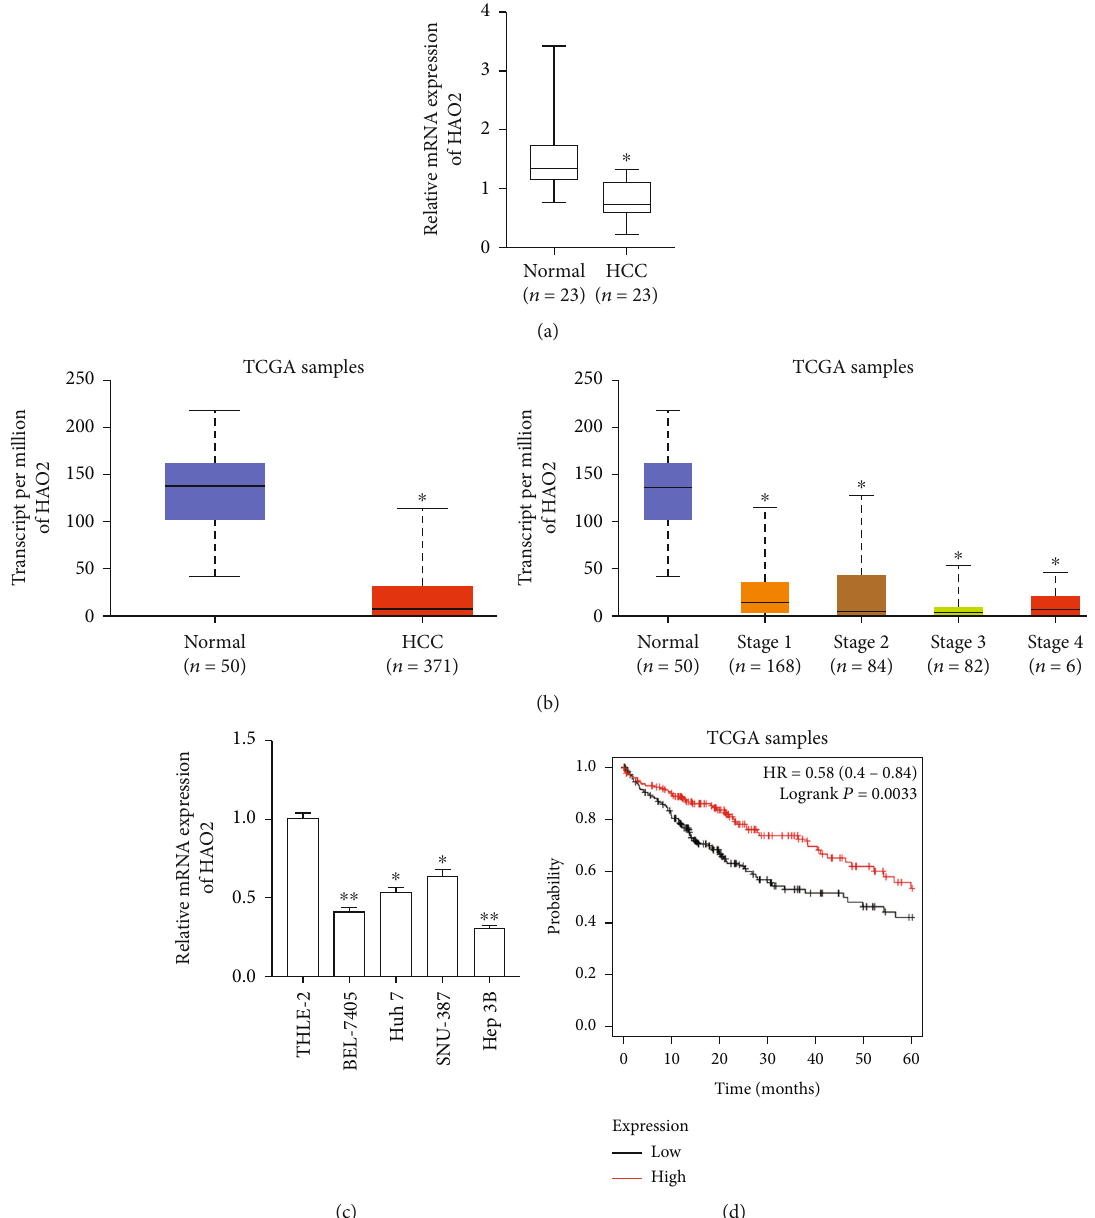
Figure 1: HAO2 is underexpressed in HCC tissues and cell lines. (a) qRT-PCR analysis of mRNA levels of HAO2 in HCC and paracancerous tissues. (b) TCGA database analysis of HAO2 levels in large samples of HCC and paracancerous tissues. (c) qRT-PCR measurement of the HAO2 expression in normal liver epithelial cells THLE-2 and 4 HCC cell lines (Hep3B, BEL-7405, Huh7, and SNU-387). (d) TCGA database analysis of the correlation between the 5-year survival rate and HAO2 expression in HCC patients. ∗ P < 0 : 05 , ∗∗ P < 0 : 01